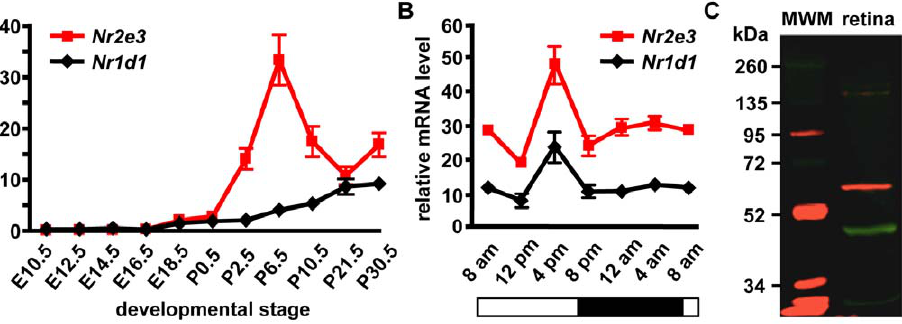
Figure 1. Nr1d1 is expressed in the developing and adult retina. A: Expression of Nr1d1 and Nr2e3 in the developing retina. Nr1d1 and Nr2e3 expression begin at embryonic day (E) 18.5 with expression persisting into the adult retina. Nr2e3 expression peaks at postnatal day (P) 6 and decreases into the adult retina, while the expression of Nr1d1 increases into the adult retina. B: Cyclic expression of Nr1d1 and Nr2e3 in the adult retina. The cyclic expression pattern of Nr1d1 and Nr2e3 show a peak in expression of both nuclear receptors at 4 pm. Bar indicates when lights are on and off during the 12 hour light-dark cycle. Quantitative RT-PCR values corrected to fit chart scale. n=3. C: Western blot performed with retinal lysates depicting NR1D1 protein at the expected size of 67 kDa (red). Beta actin was used as a control (green). MWM: molecular weight